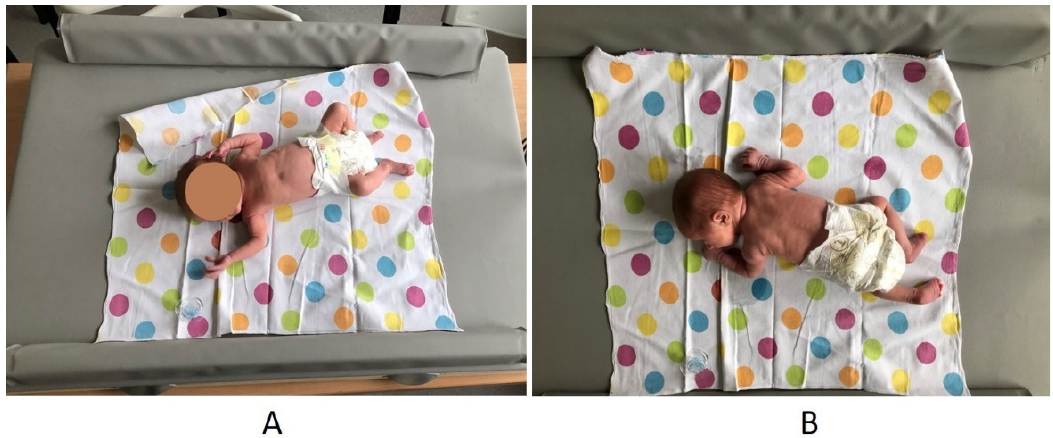
Figure 2. Posturometric test in supine ( A ) and prone ( B ) positions. Table 2. The posturometric indices are based on CoP shifts, and the posturometric indices are based on the surface area of the CoP during lying [34].